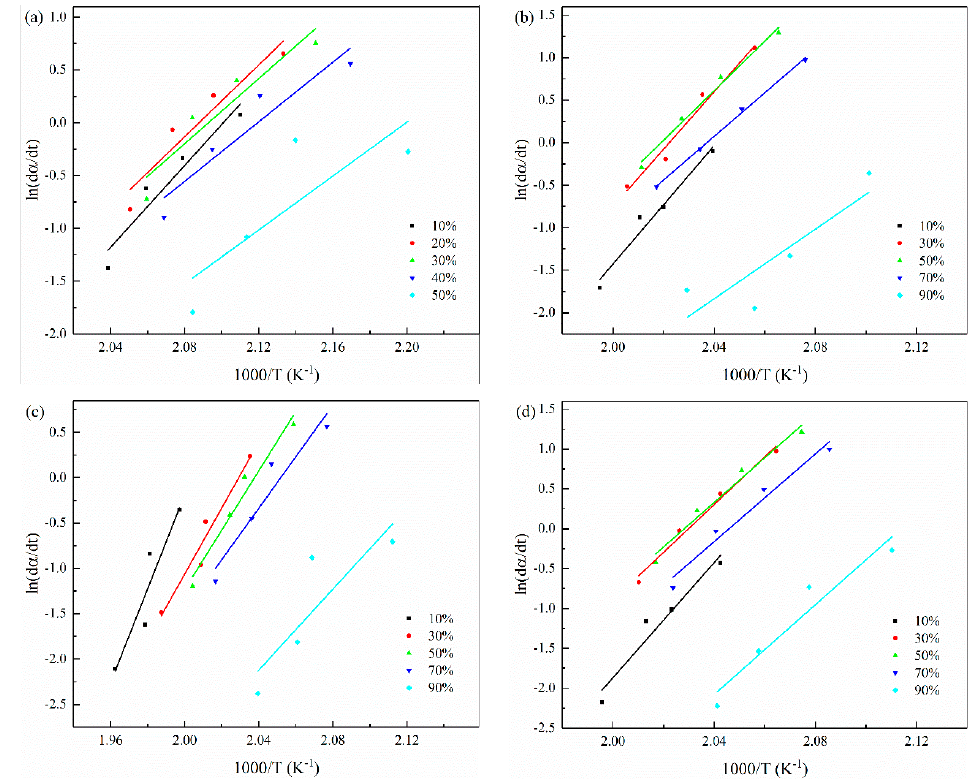
Figure 12. Friedman plots constructed from non-isothermal crystallization rate data: ( a ) (56 wt%)